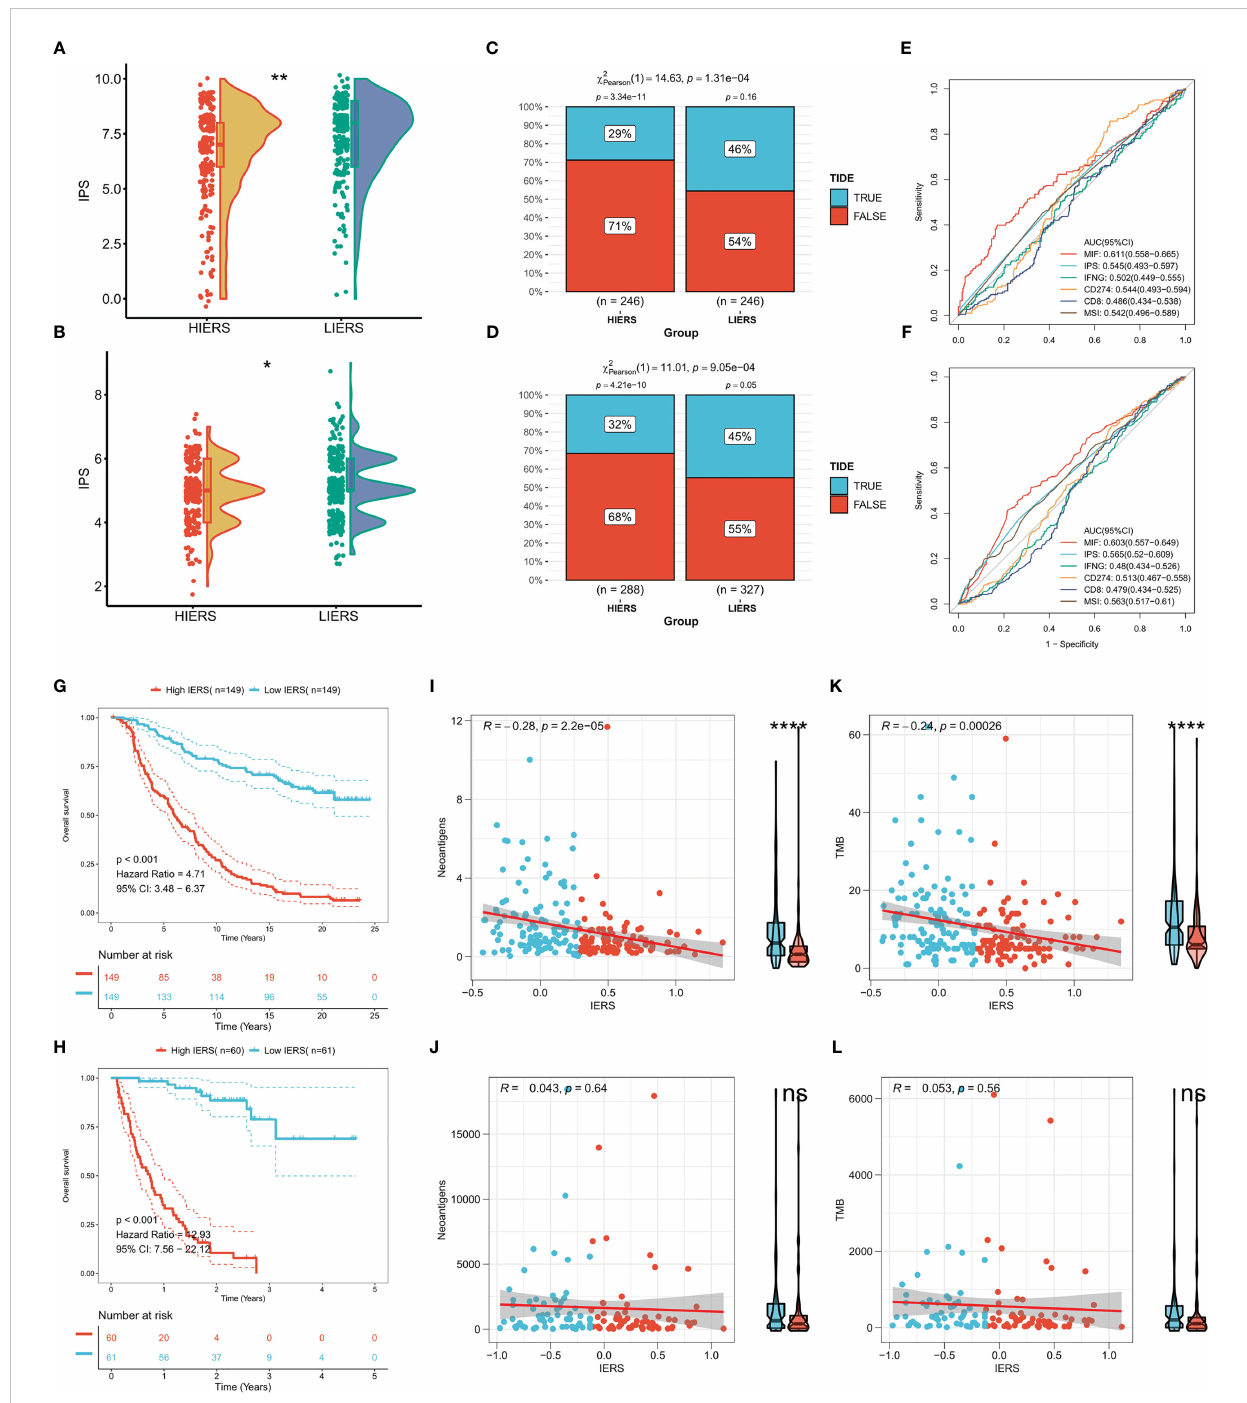
FIGURE 9 Potential of IERS to predict immunotherapy The boxplot showed the distribution of IPS between different IERS subgroups in the (A) TCGA and (B) meta-GEO cohorts. TIDE algorithm predicts response to immunotherapy of different IERS subgroups in (C) TCGA and (D) meta-GEO cohort. ROC curves assess the predictive accuracy of different immune-related metrics for immunotherapy bene fi ts in the (E) TCGA and (F) meta-GEO cohorts. KM survival curves for patients in the high- and low-IERS groups in (G) Imvigor210 and (H) Nature-SKCM cohort. Box plots and scatter plots showed the correlation between IERS and neoantigens in (I) Imvigor210 and (J) Nature-SKCM cohort. Box plots and scatter plots showed the correlation between IERS and TMB in (K) Imvigor210 and (L) Nature-SKCM cohort. ns P<0.05, *P<0.05, **P<0.01,